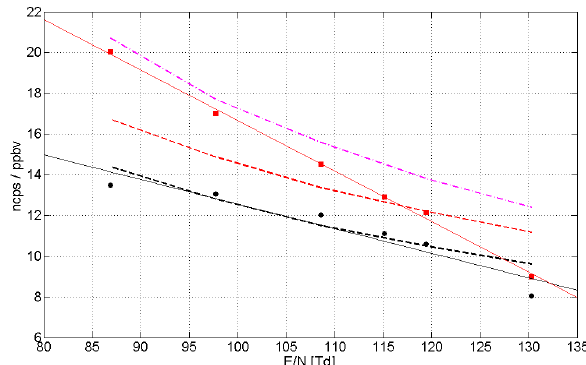
Figure 4: Normalized sensitivities plotted as a function of E/N. Isoprene (black) and 232 5 Fig. 4. Normalized sensitivities plotted as a function of E/N . Iso-